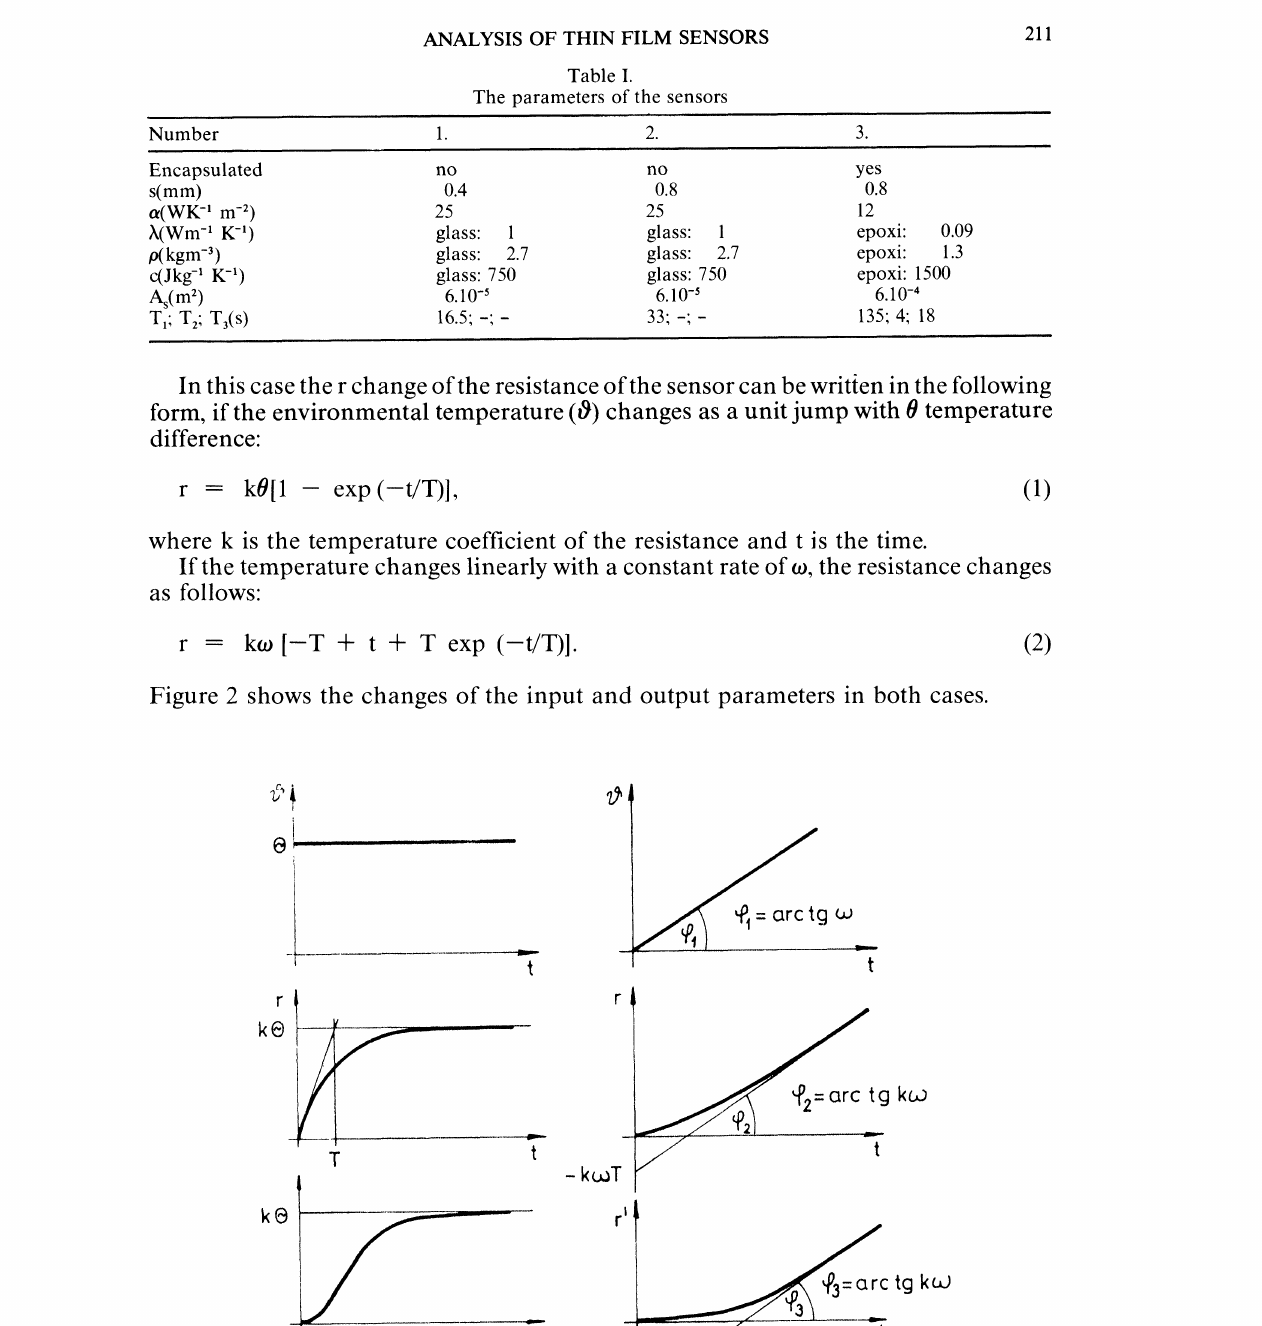
FIGURE 2 Behaviour of thin film